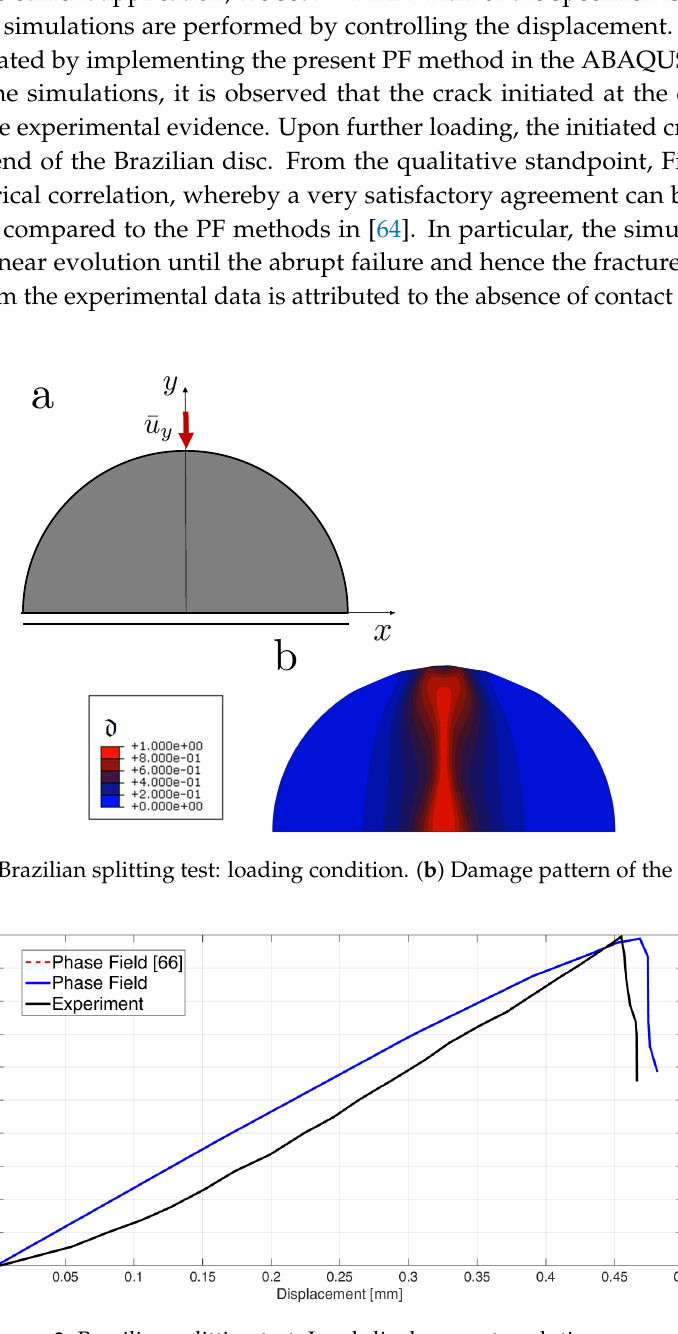
Figure 3. Brazilian splitting test: Load-displacement evolution